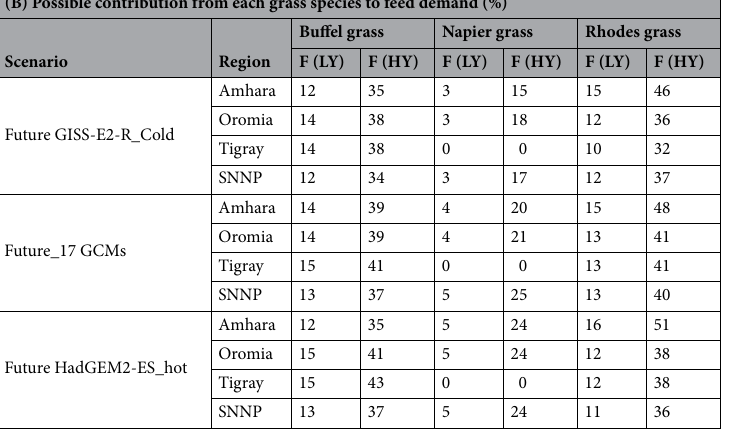
Table 2. Possible contribution of Buffel, Napier and Rhodes grasses to meet total feed demand (%) under Scenario A and Scenario B, calculated based on the area suitable for individual grass assuming that all land will be used only for monocrop culture production under predicted future conditions, if (A) 15% and (B) 10% of total land is used for pasture. F (LY) = ‘fertilized (business as usual, average yield 5.7 tons per ha)’, F (HY) ‘fertilized (highest reported yield for the species as per Table 1)’. All values are presented as ± 28%, based on the mean, min and max yield for each grass species under Scenario A and Scenario